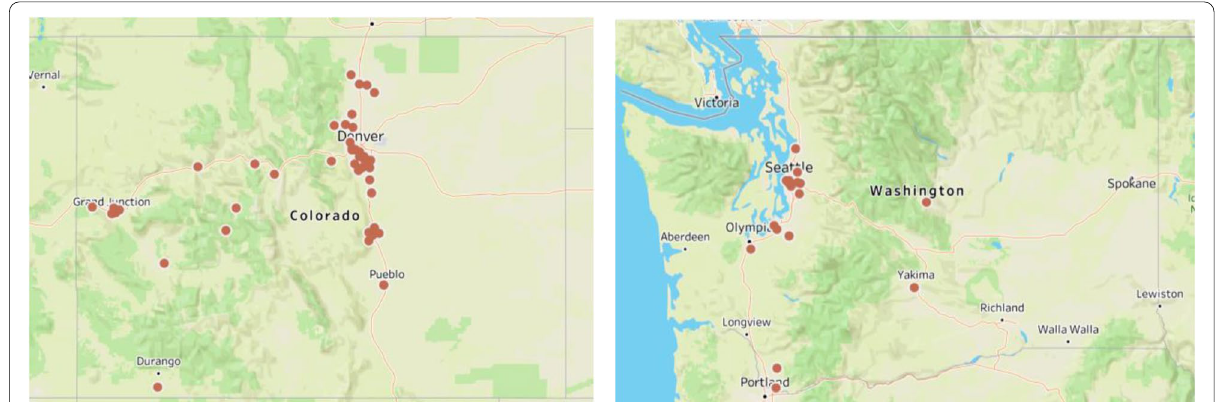
Fig. 2 Location of participants by zip code in Colorado and Washington